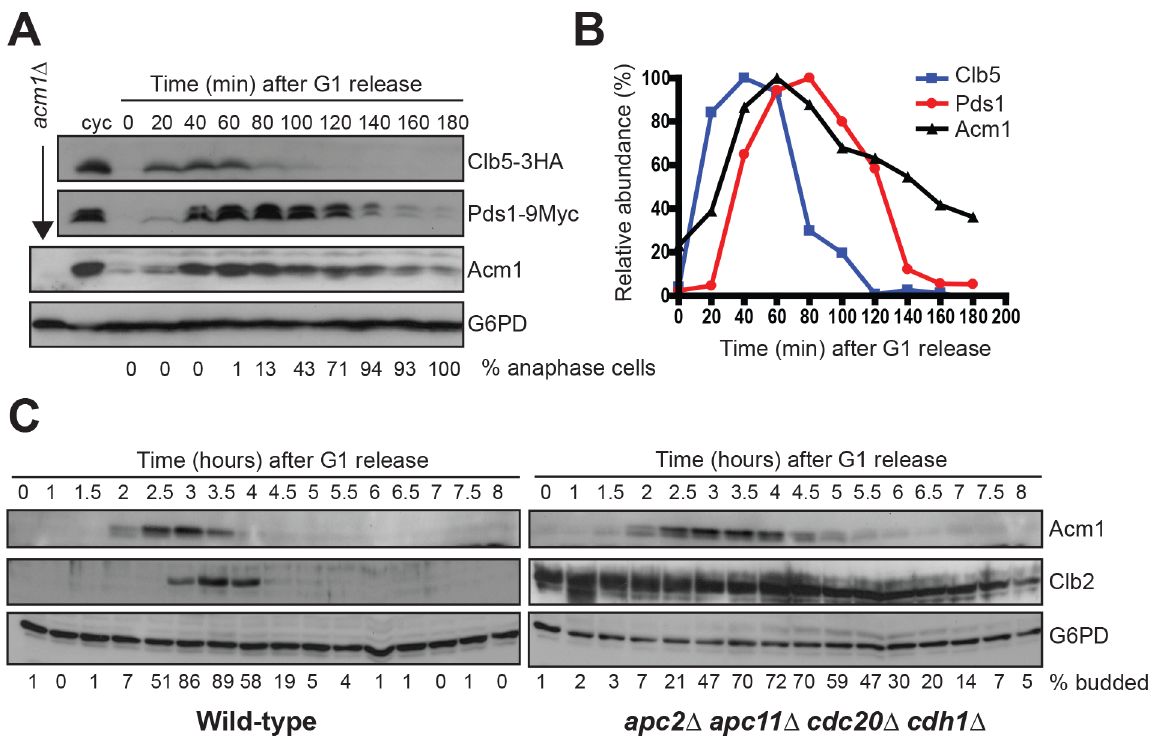
Figure 1. APC Cdc20 is neither necessary not sufficient for complete Acm1 degradation at mitotic exit. A) dbf2-2 cells expressing endogenous chromosomally tagged Clb5-3HA and Pds1-9Myc were released from a G1 arrest at 37 u C and the levels of Clb5, Pds1, and Acm1 monitored by immunoblotting over the indicated time period. G6PD is a loading control. Numbers under each lane were obtained by fluorescence microscopic analysis of at least 100 cells at that timepoint stained with DAPI and scored for the presence of 2 segregated DNA masses indicative of the dbf2-2 late anaphase arrest point. cyc, asynchronous cycling cultures. B) Protein levels were quantified from the immunoblots in panel A. The abundance of each protein was plotted as a percentage of its maximal expression level. C) Extracts from synchronized cultures of yBRT135 (Wild-type) and mutant strain yBRT159 lacking several subunits of APC ( apc2 D apc11 D cdc20 D cdh1 D pds1 D clb5 D SIC1 10x ) were generously provided by David Toczyski [17], and were probed for Acm1, Clb2, and the loading control G6PD by immunoblotting. The budding index under each lane, taken from [17], is used as an indicator of cell cycle progression.